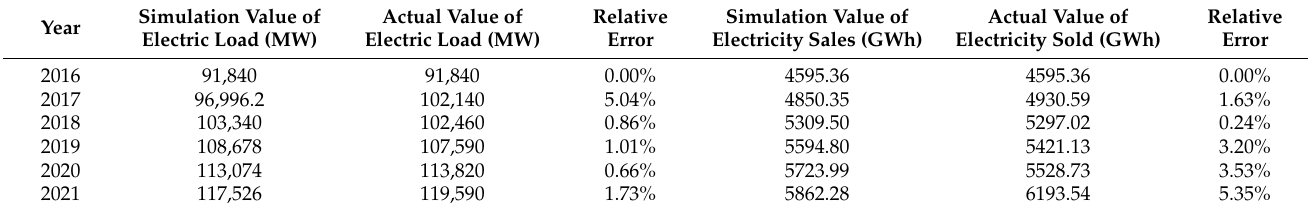
Table 5. Comparison between simulation value and actual value of key indicators of governance